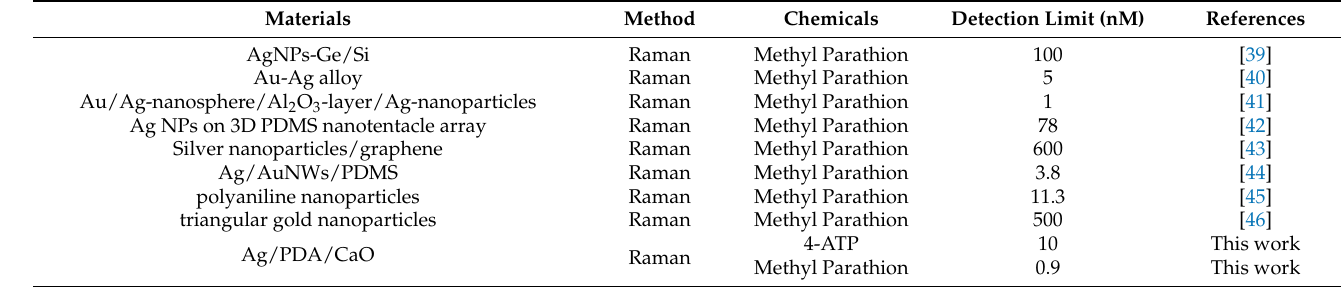
Table 1. Comparison of various SERS substrates in methyl parathion